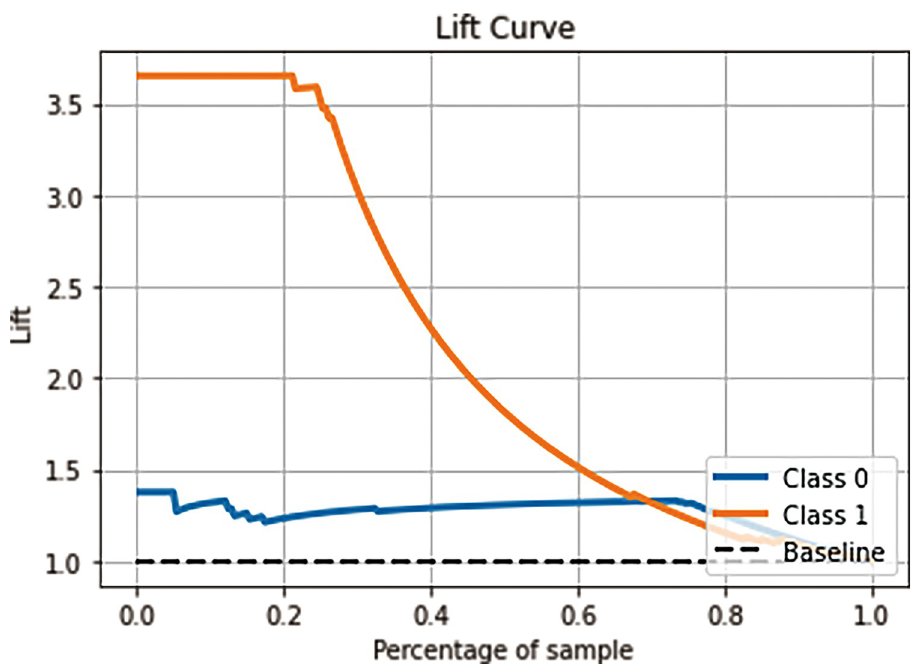
Fig 8. The Lift curve with Support Vector Machine model. “Class 0” indicates IgAN patients with none conbined endpoint progression, and “Class 1” indicates IgAN patients with the conbined endpoint progression.